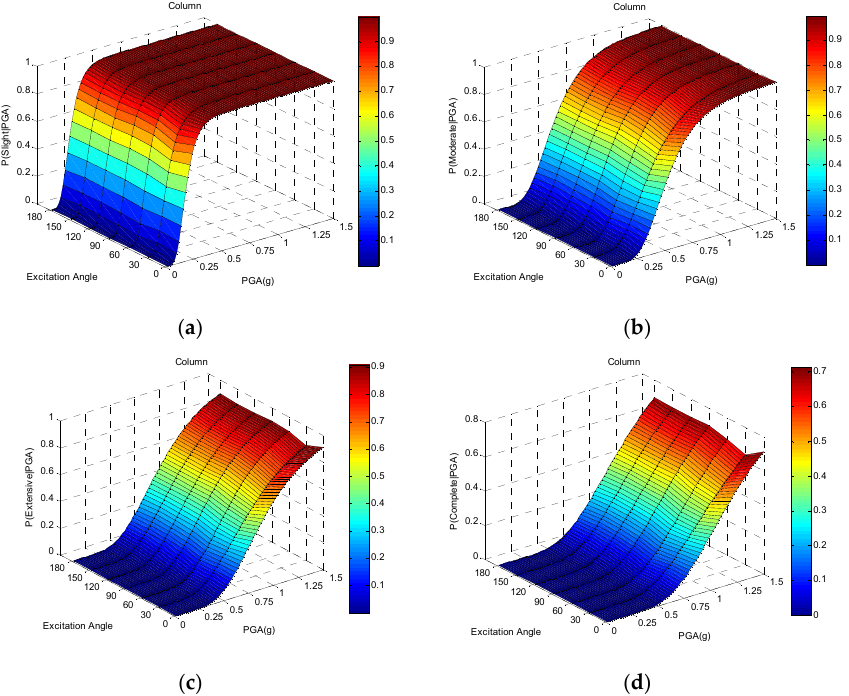
Figure A1. Seismic fragility surfaces of Column subjected to different excitation angles in the ( a ) slight; ( b ) moderate; ( c ) extensive; and ( d ) complete limit states.